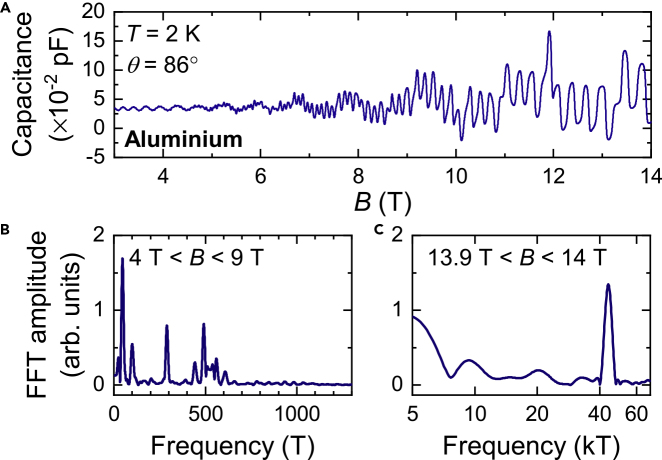
Magnetic Torque Quantum Oscillations in Single Crystals of Elemental Aluminum(A) Quantum oscillations in the magnetic torque of Aluminum single crystals measured in this study as a function of magnetic field. The field is aligned 86° from the [001] direction in the [001]-[111]-[110] rotational plane.(B and C) Fourier transforms of the measured magnetic torque as a function of inverse magnetic field in the field ranges (B) 4 T < B < 9 T and (C) 13.9 T < B < 14 T, revealing multiple frequency peaks up to 500 T, and a very high frequency peak of 40 kT, when taking a narrow field window, corresponding to the ψ branch (see Figure 9B).